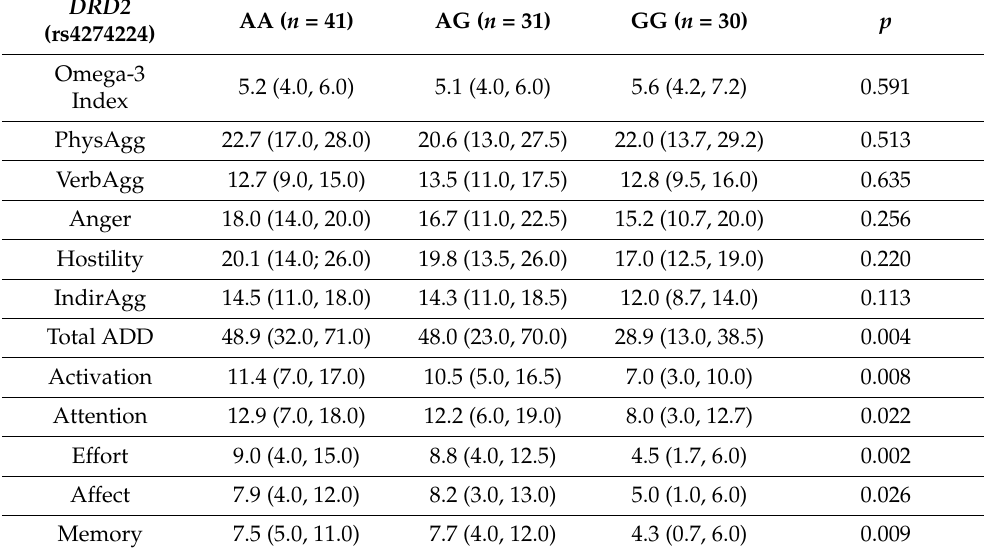
Table 3. DRD2 genotypes analysis according to Omega-3 Index and neuropsychological testing.